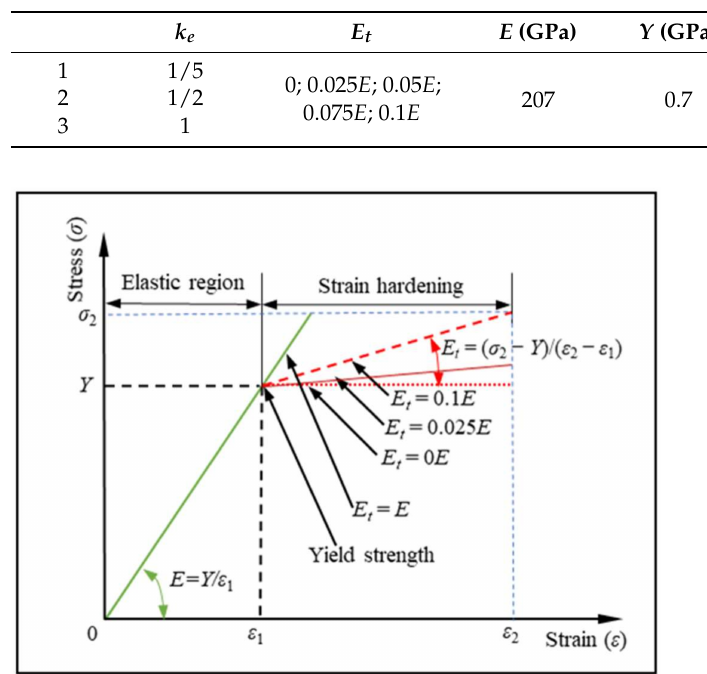
Figure 2. Ellipsoidal finite element contact model. Table 1. Material properties.